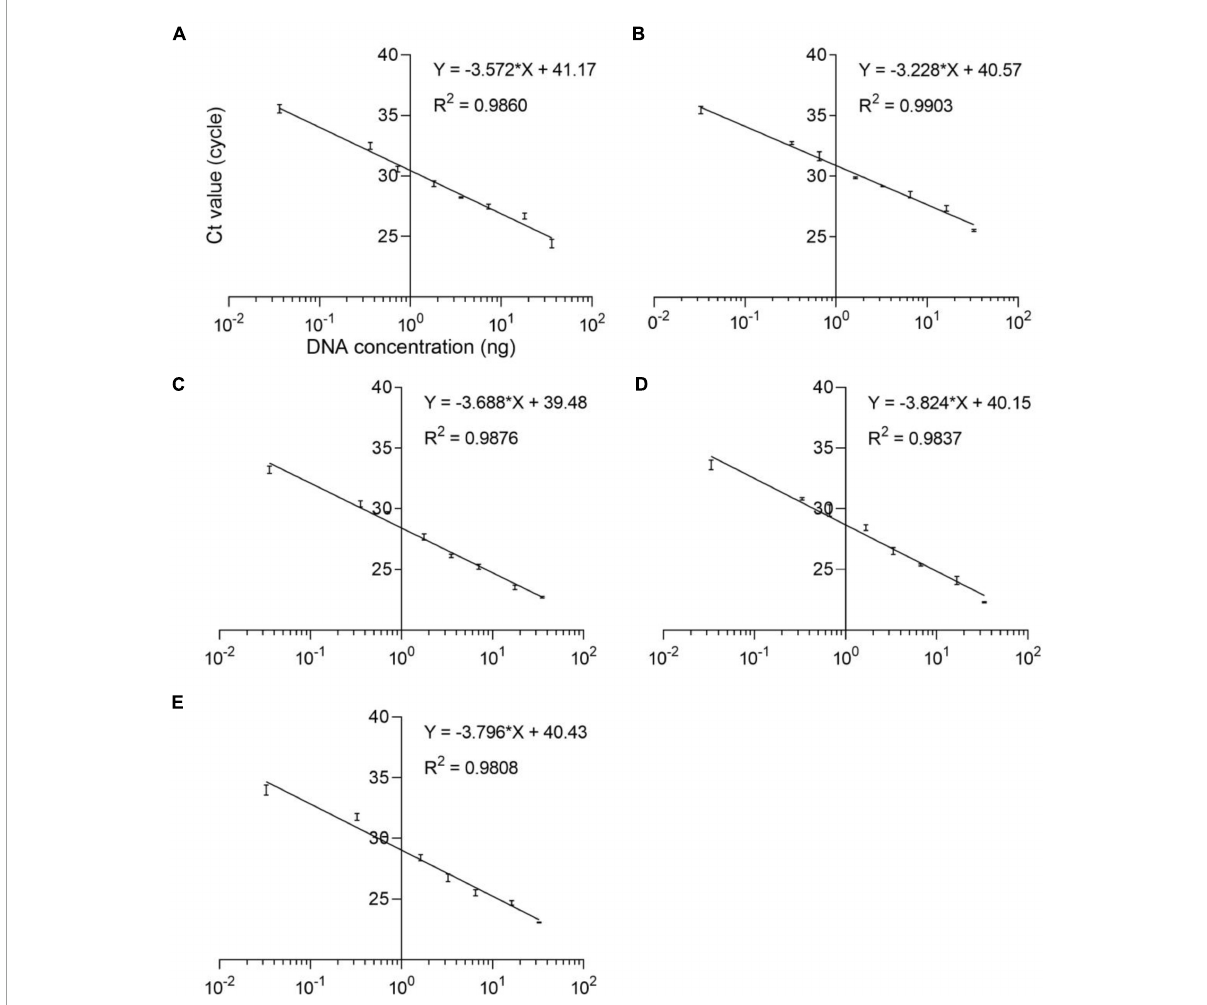
FIGURE3 Standard curves of the analyses of eight dilution levels for the real-time qPCR assays. (A) L. inermis , (B) L. lagocephalus , (C) L. gloveri , (D) L. lunaris , (E) L. spadiceus . All samples were analyzed three